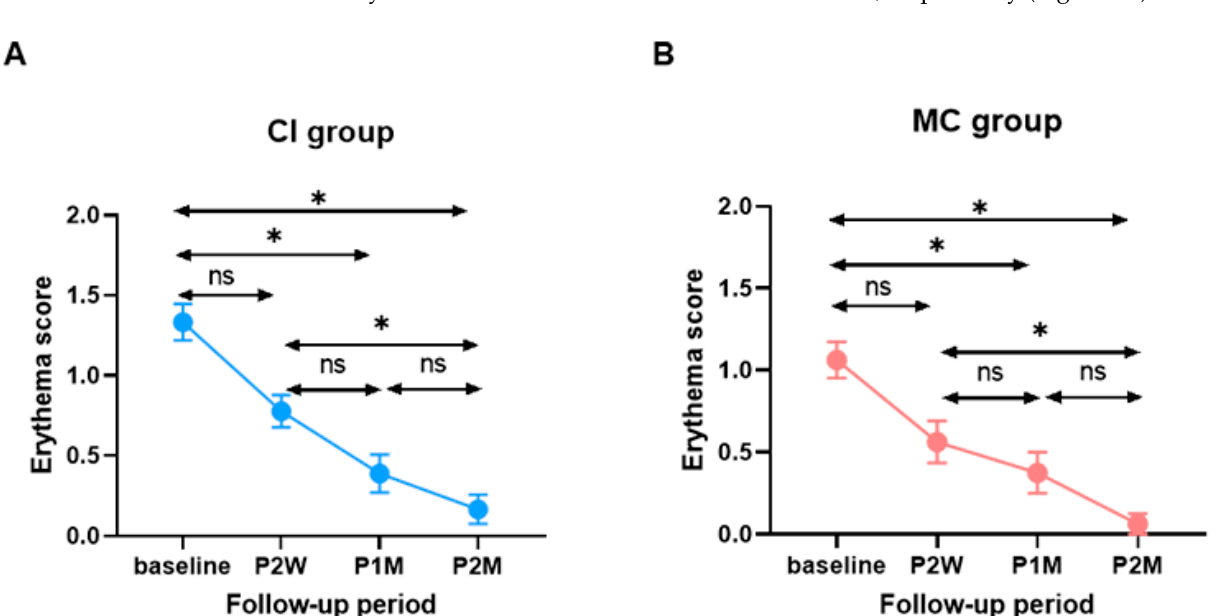
Figure 4. Classification of treatment response with reference to subjective improvement of itching sensation between the two groups. ( A ) Among the 39 ears in the CI group, 30 (76.9%), 4 (10.3%), and 5 (12.8%) met the criteria for “much im- proved”, “slightly improved”, and “stationary”( B ) The proportion of patients with “rebound” was 3 (10.0%), 2 (50.0%), and 3 (60.0%) in the “much improved”, “slightly improved”, and “stationary” groups CI, topical calcineurin inhibitor; MC, moisturizing cream.